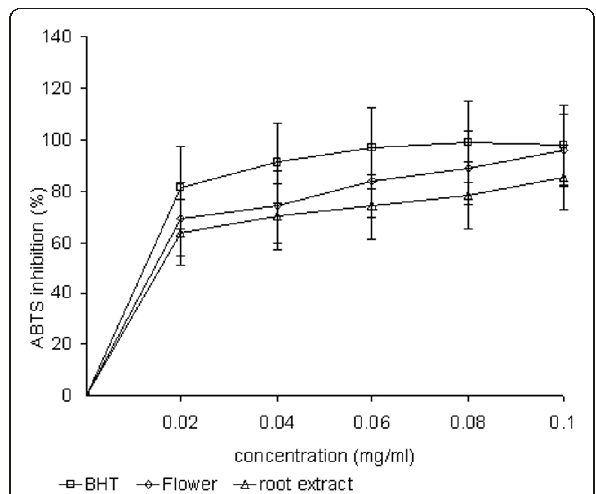
Figure 2 ABTS activities of the methanolic extracts of the flowers and roots of P. venusta .